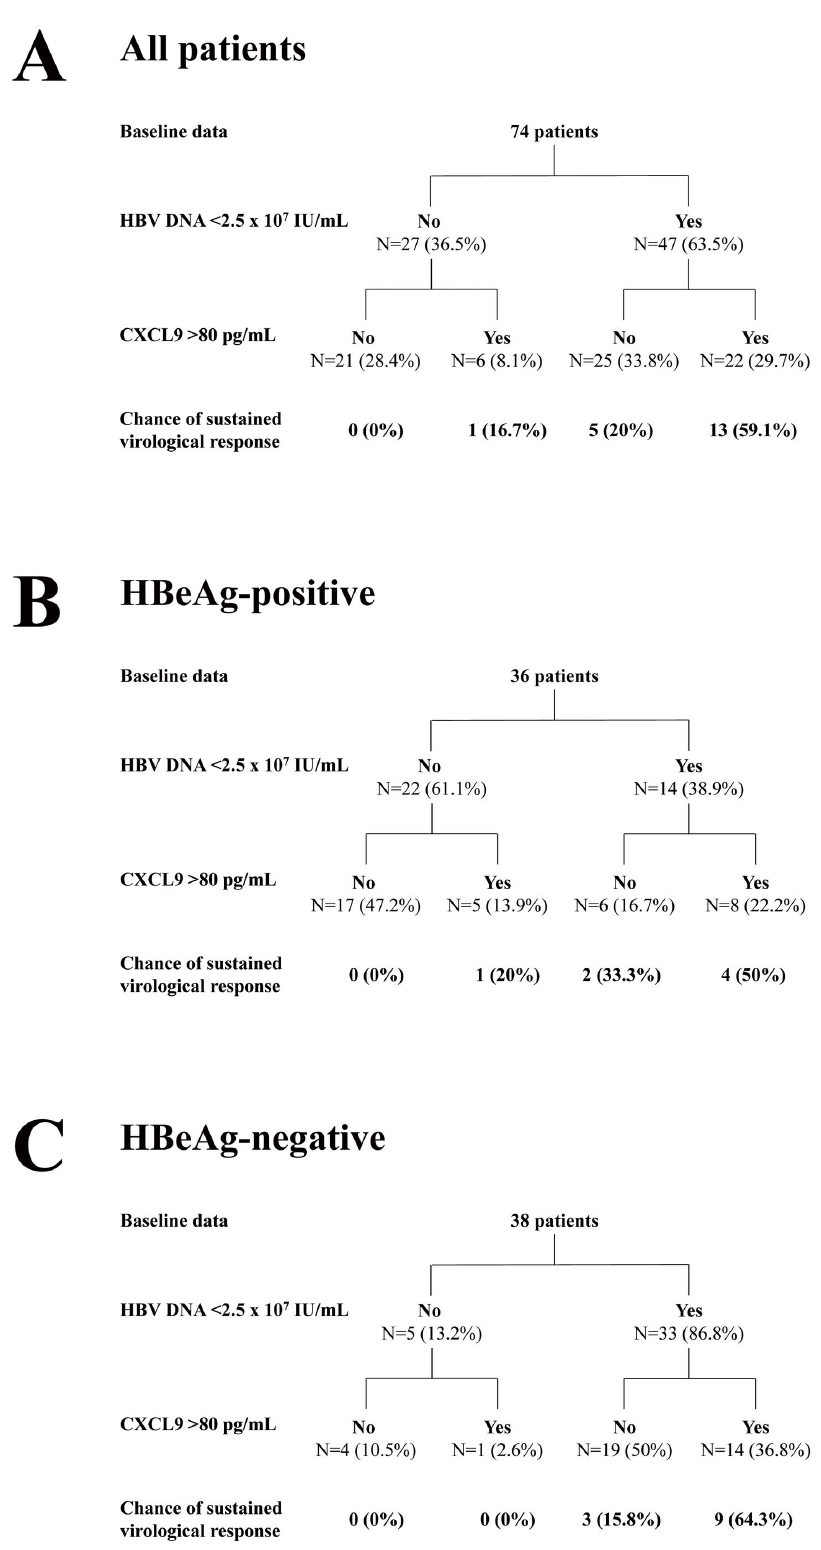
Figure 3. Prediction algorithm based on baseline serum CXCL9 level and HBV viral load. The prediction algorithm applied for all (A), HBeAg-positive (B) and HBeAg-negative CHB patients (C). doi: 10.1371/journal.pone.0076798.g003 PLOS ONE |